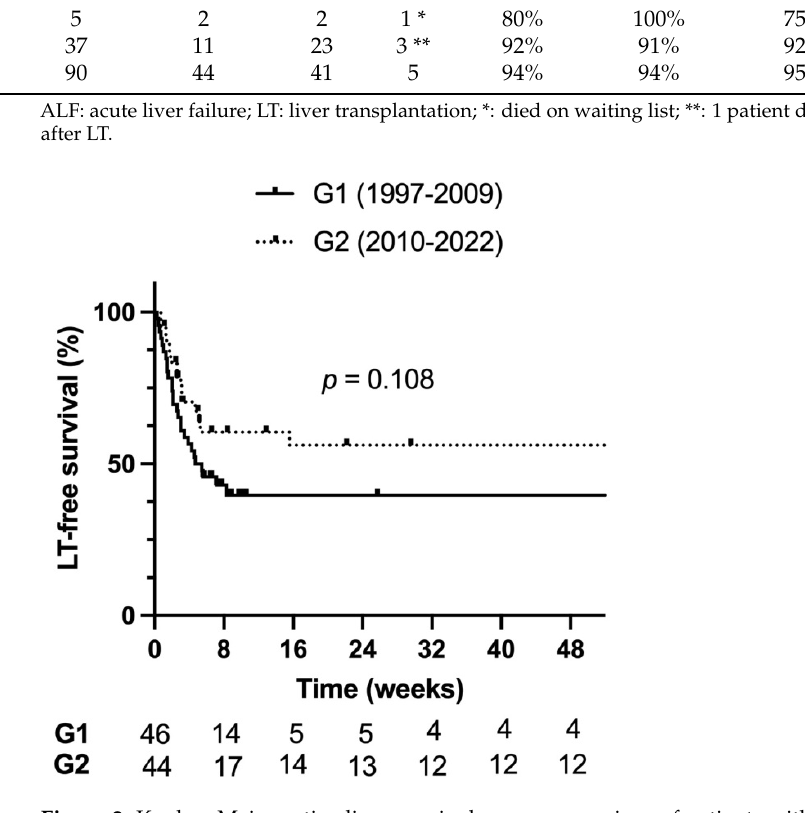
Figure 2. Kaplan–Meier native liver survival curve comparison of patients with ALF according to era. LT: liver transplant. G1: group 1. G2: group 2.